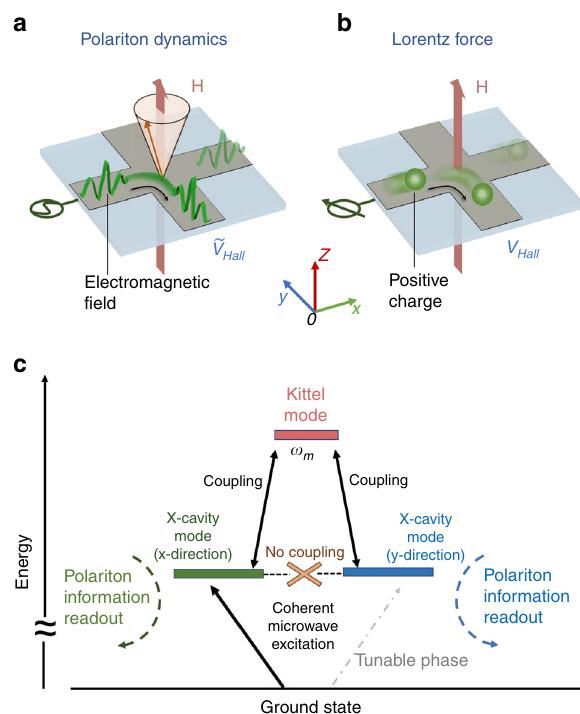
Fig. 2 Drawing analogy between X-CMP transport and Hall effect. a Schematic diagram of the dynamic Hall effect. Construction of X-CMP dynamics leads to the de fl ection of polariton fl ow from the x -direction toward the y -direction. b Schematic diagram of the Hall effect. A charge current fl ows along the x -direction. The Lorentz force acts on the charge, producing a static Hall signal. In both ( a , b ) the external applied static magnetic fi eld H is along the z- direction, perpendicular to the sample plane. c A description of the coupling between a magnon and the X-cavity. The energy diagram illustrates the frequencies of the degenerate cavity modes ω ω c as well as the magnon mode m . The magnon couples to the X-cavity modes with a coupling strength of Ω 0 NATURE COMMUNICATIONS| (2019) 10:2934